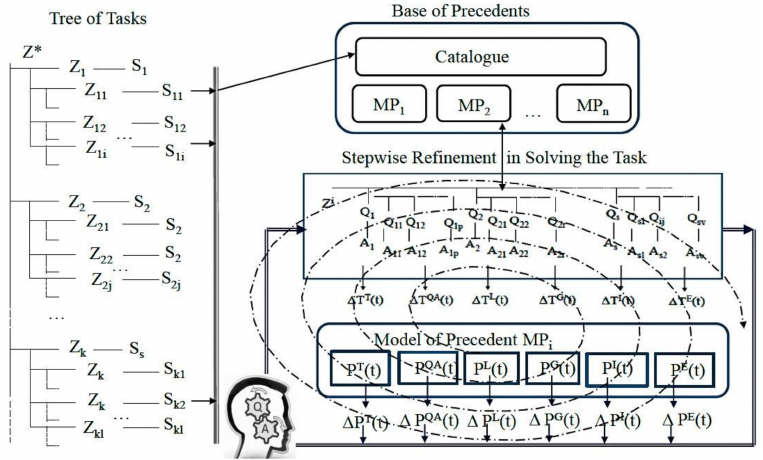
Figure 11. Creating the model of the precedent.